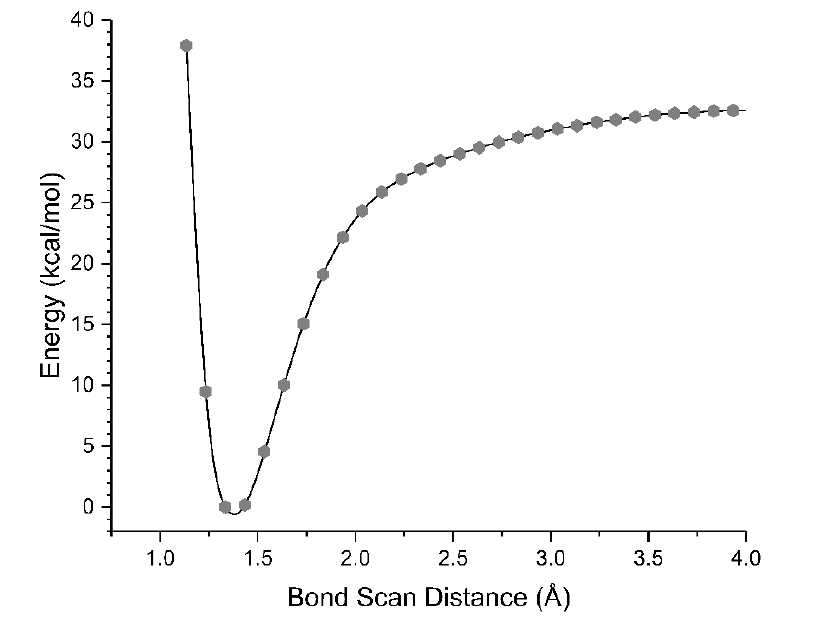
Figure 6: Homolytic BDE of phenyl diazonium